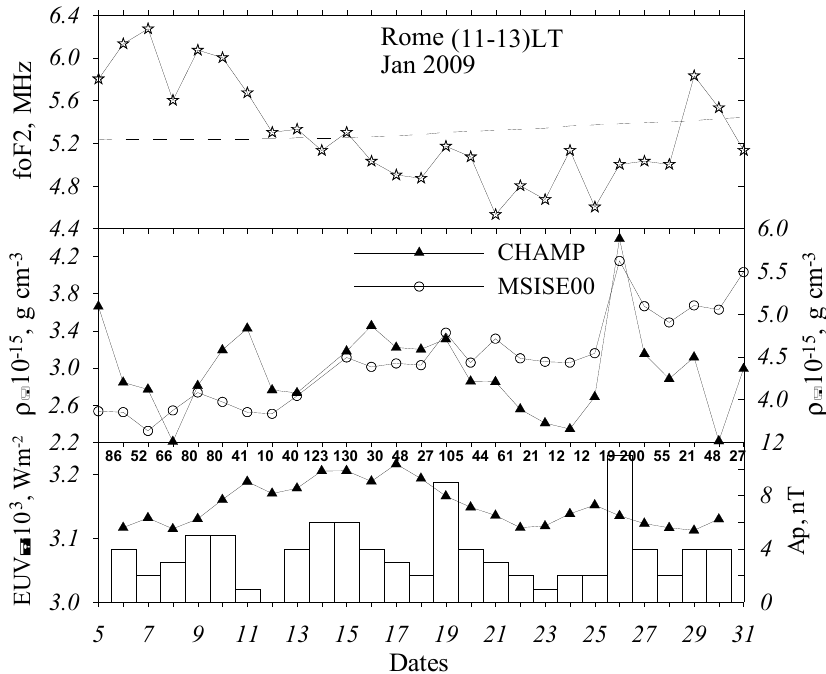
Figure 3. Daily f o F 2 variations at Rome during the SSW event in January 2009. Dashes—model monthly median f o F 2 for 12 LT. The neutral gas density in the evening sector observed with CHAMP (left y -axis) is given in comparison to the MSISE00 model variations at the latitudes of Rome (right y -axis). Daily solar EUV (triangles) and Ap indices are given in the bottom panel. Numbers along x -axis (middle panel)—daily AE indices.